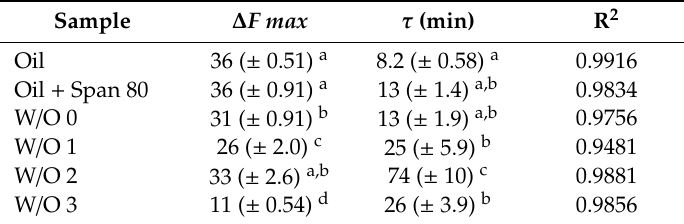
Table 3. Values of ∆ F max and τ calculated from fitting fluorescence data to Equation (14). The same letters are not statistically different among treatments by the Tukey test ( p < 0.05).